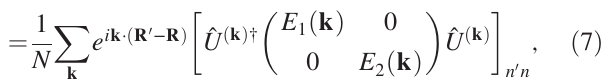
FIG. 4. Hopping integrals in the effective tight-binding model for the low-energy flat band of TBG at θ ¼ 1 . 05 °. Panels (a) and (b) present the hopping parameters from the Wannier orbitals 1 and 2, respectively, where the radius of the circle at each lattice point indicates the absolute value of the hopping integral from the origin to that point, and the direction of the bar represents the phase in the complex